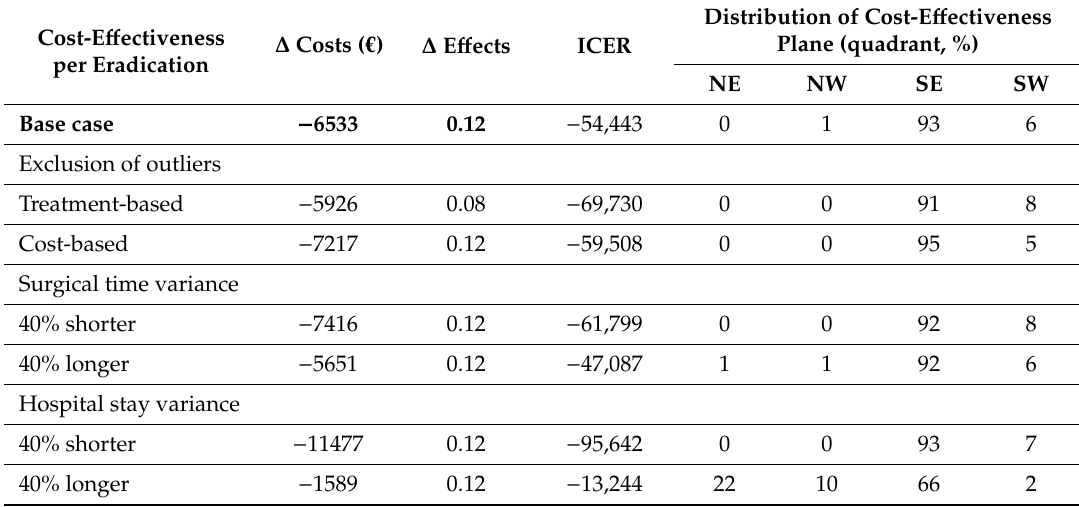
Table 4. Results of di ff erent Sensitivity Analyses (e ff ects applied only on the treatment